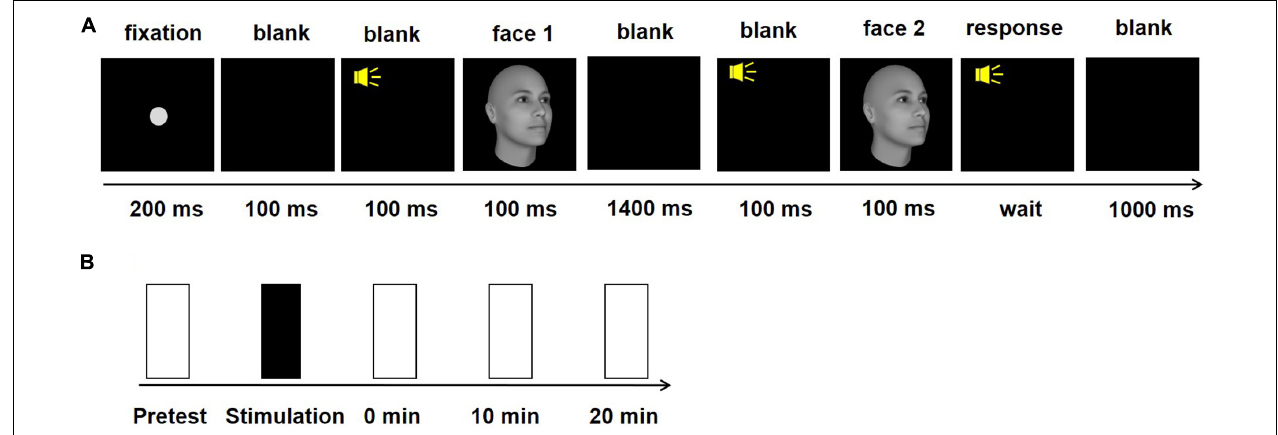
FIGURE 1 | Task and procedure in experiment 1. (A) Schematic description of a trial in the 2-AFC face view discrimination task. (B) The experimental procedure in one session. The black rectangle indicates anodal, cathodal or sham stimulation. The white rectangles indicate the four test blocks.